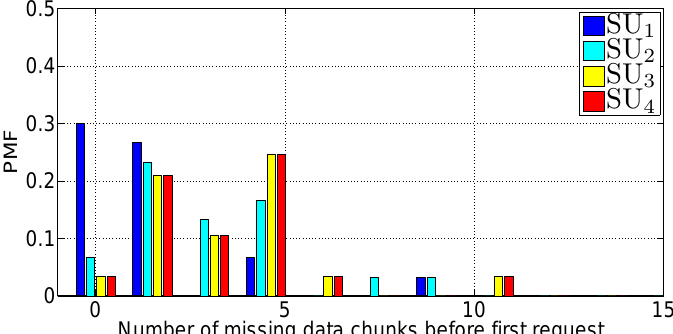
Figure 23. PMF of the number of missing DATA fragments before the transmission of the first REQUEST message in Scenario 3.